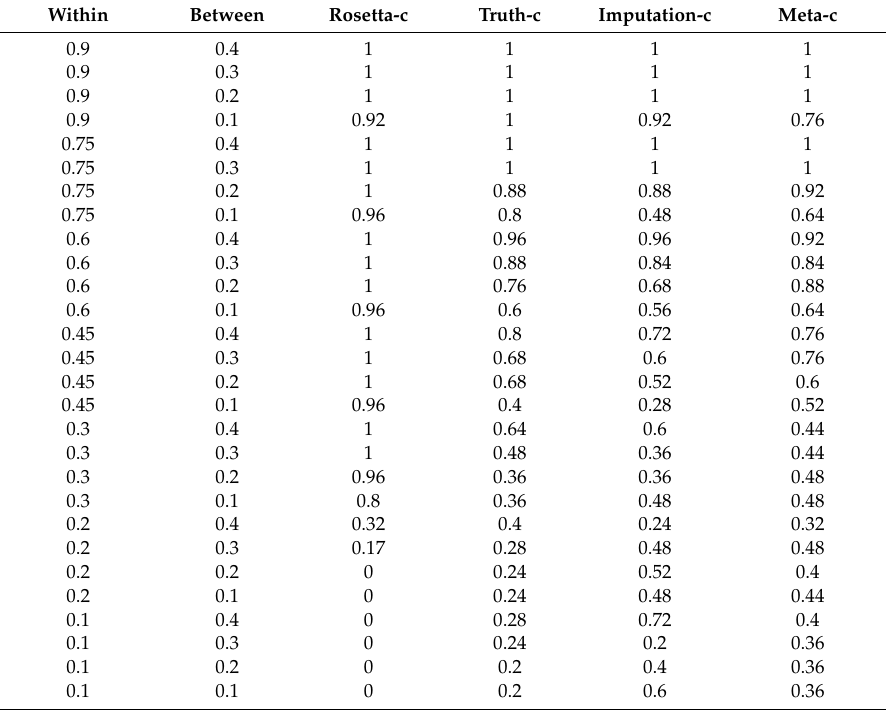
Table 6. Study 3: Power of Each Method by Within-Domain and Between-Domain Correlation. Within Between Rosetta-c Truth-c Imputation-c